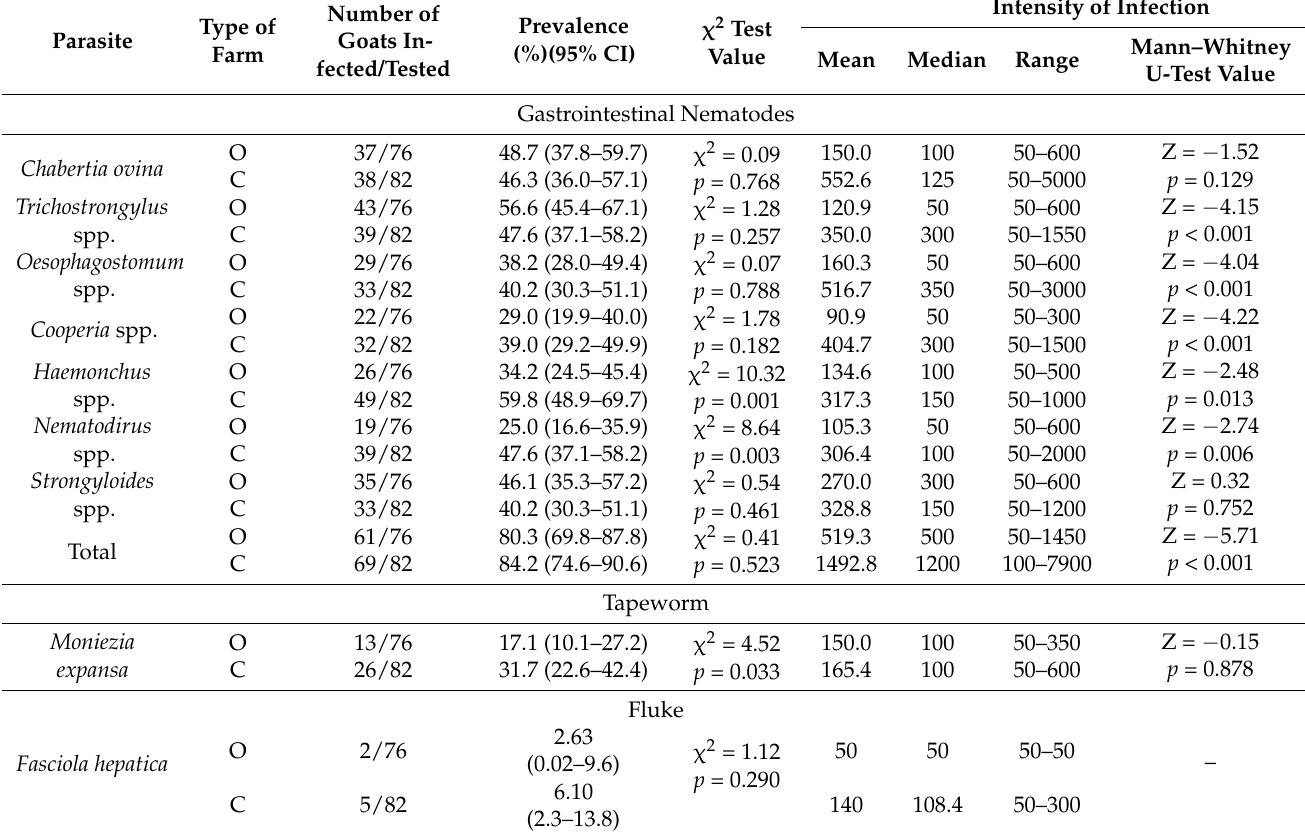
Table 6. Prevalence and intensity of infections with helminths in the studied